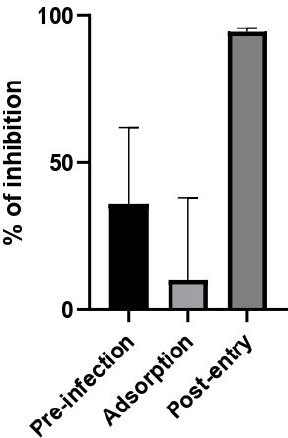
Figure 6. Antiherpetic activity and cytotoxicity of Saussurea costus aqueous extract. ( A ) Vero cells were incubated with increasing concentrations of the extract, and after 72 h, the cytotoxicity was measured as described in Section 2. ( B ) Vero cells were infected at MOI 1.5 with HSV-1 and incu- bated with increasing concentrations of the extract. After 72 h, the virus genome production was quantitated in the supernatant by qPCR. The % of inhibition was determined as the ratio between treated and untreated infected cells. Data are expressed as mean +/− SD for n = 2.